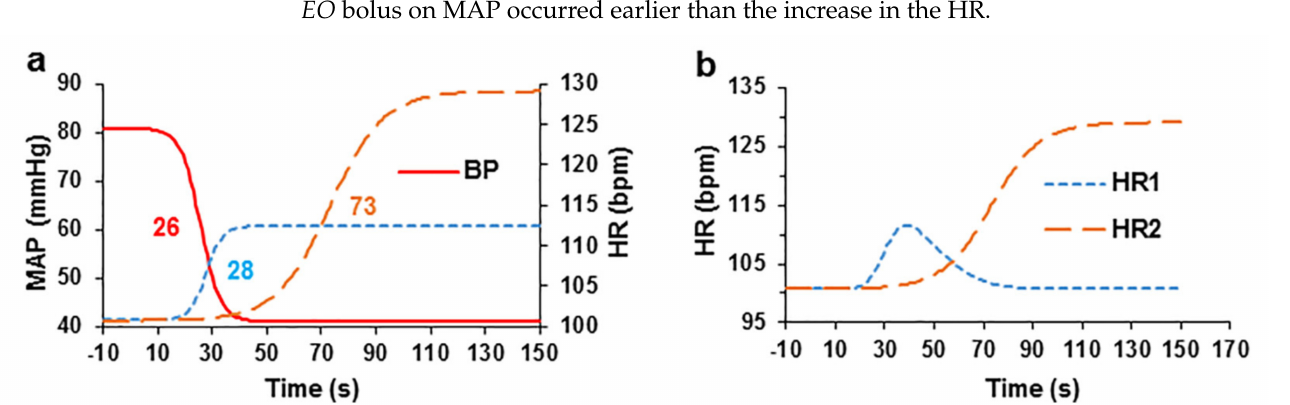
Figure 3. Interdependence of blood pressure and HR after intravenous administration of the EO bolus in pigs. ( a ) The relationship between blood pressure and HR components after administration of the EO bolus (all curves were fitted with sigmoidal logistic curves). The numbers next to the curves indicate the half-lives from the start of administration of the EC bolus. ( b ) The curves for the two HR components that were fitted with an asymmetric Gaussian curve (first component, HR1) and with a sigmoidal logistic curve (second component, HR2), n =